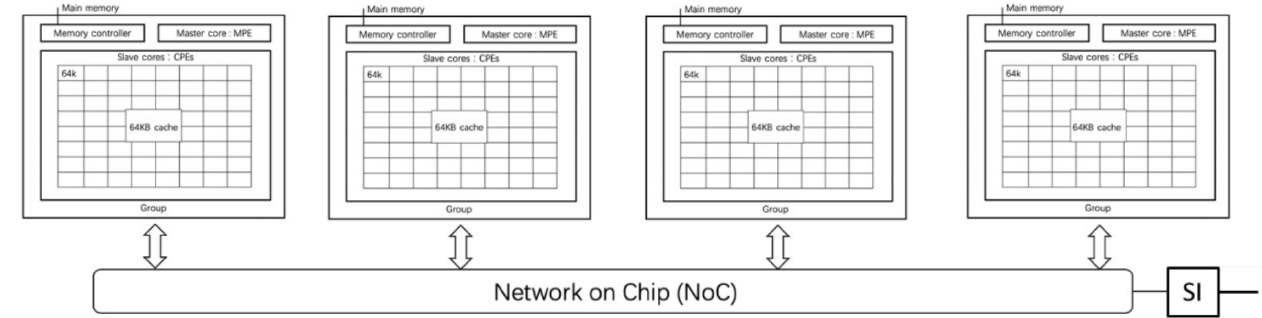
Figure 1. A schematic illustration of the general architecture of the Sunway SW26010 CPU. Each CPU consists of four core groups, and each core group includes a memory controller, a master core (i.e. MPE – management processing element), and 64 slave cores (i.e. CPEs – computing processing elements), each of which has a 64KB scratchpad fast memory that is called LDM (local data memory). The four core groups are linked together by the network on a chip, and the whole CPU is linked with other CPUs by the system interface (SI)